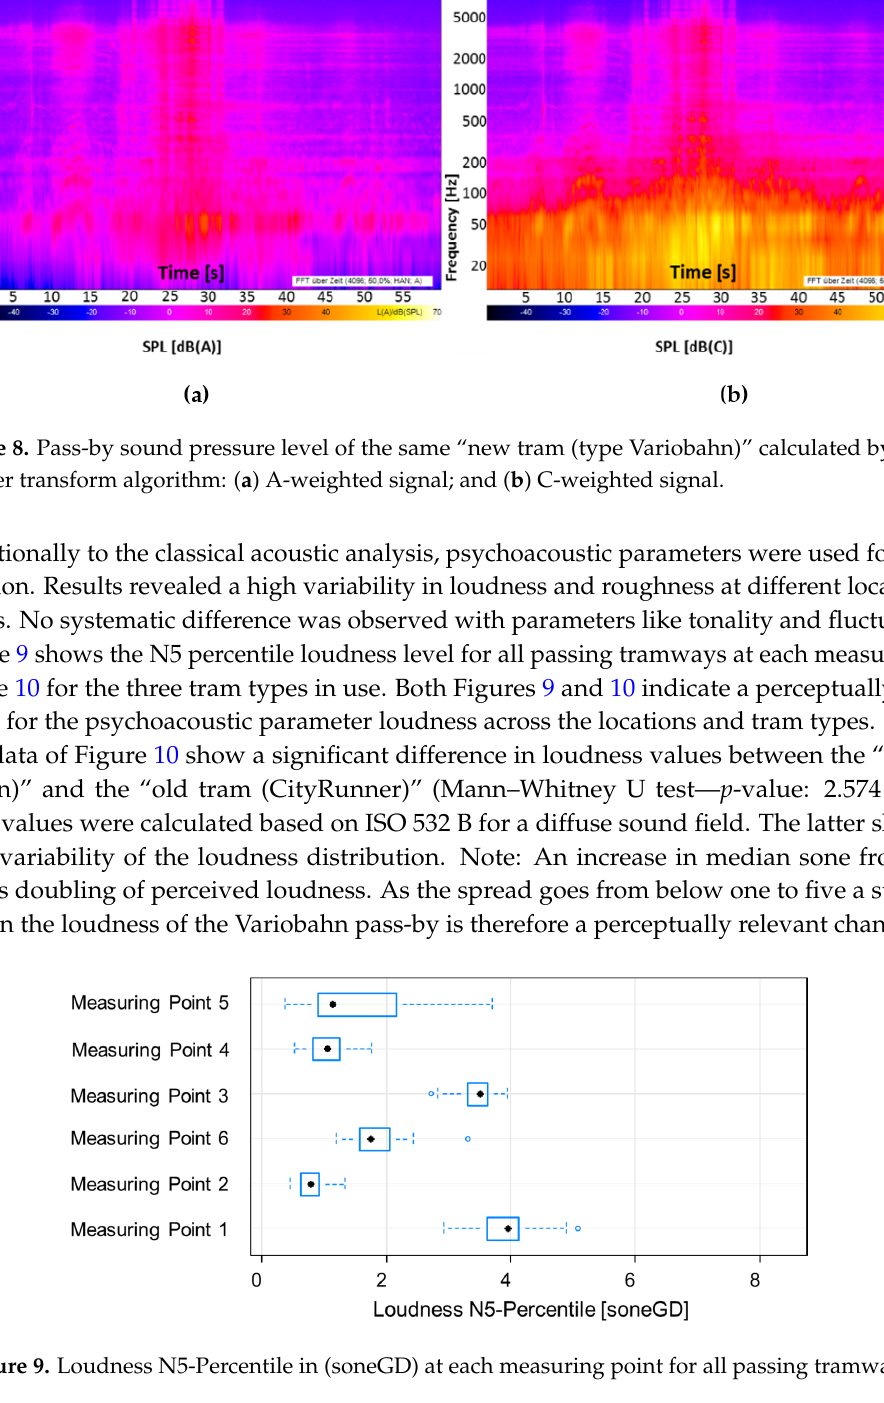
Figure 9. Loudness N5 ‐ Percentile in (soneGD) at each measuring point for all passing